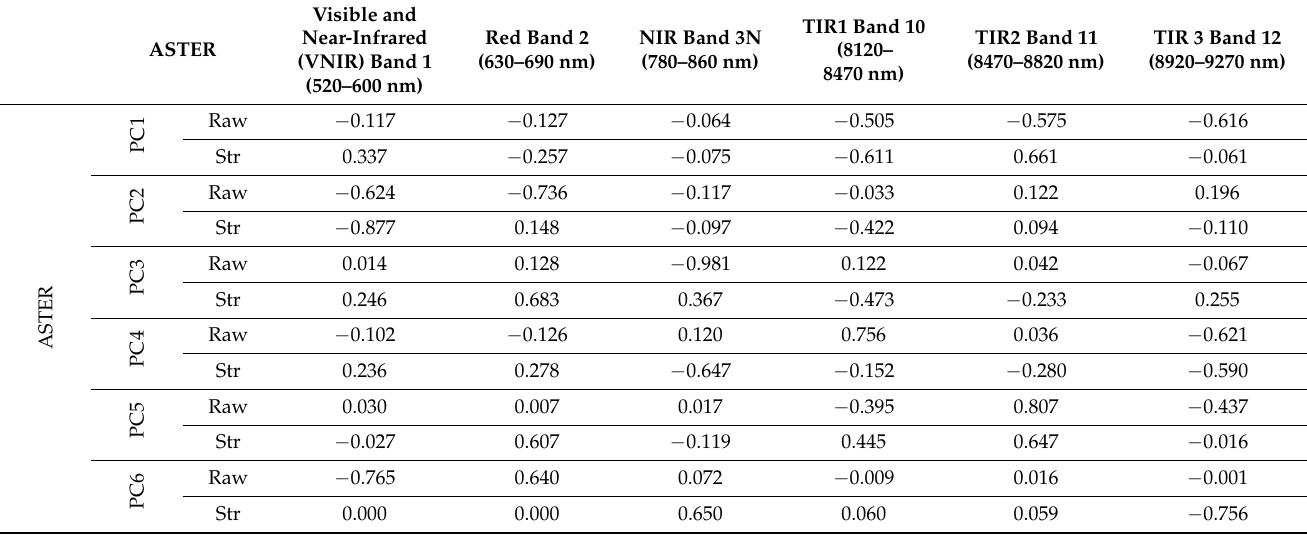
Table 3. Eigenvector loadings after applying FPCS on the raw (Raw) and stretched (Str) ASTER LIT data.